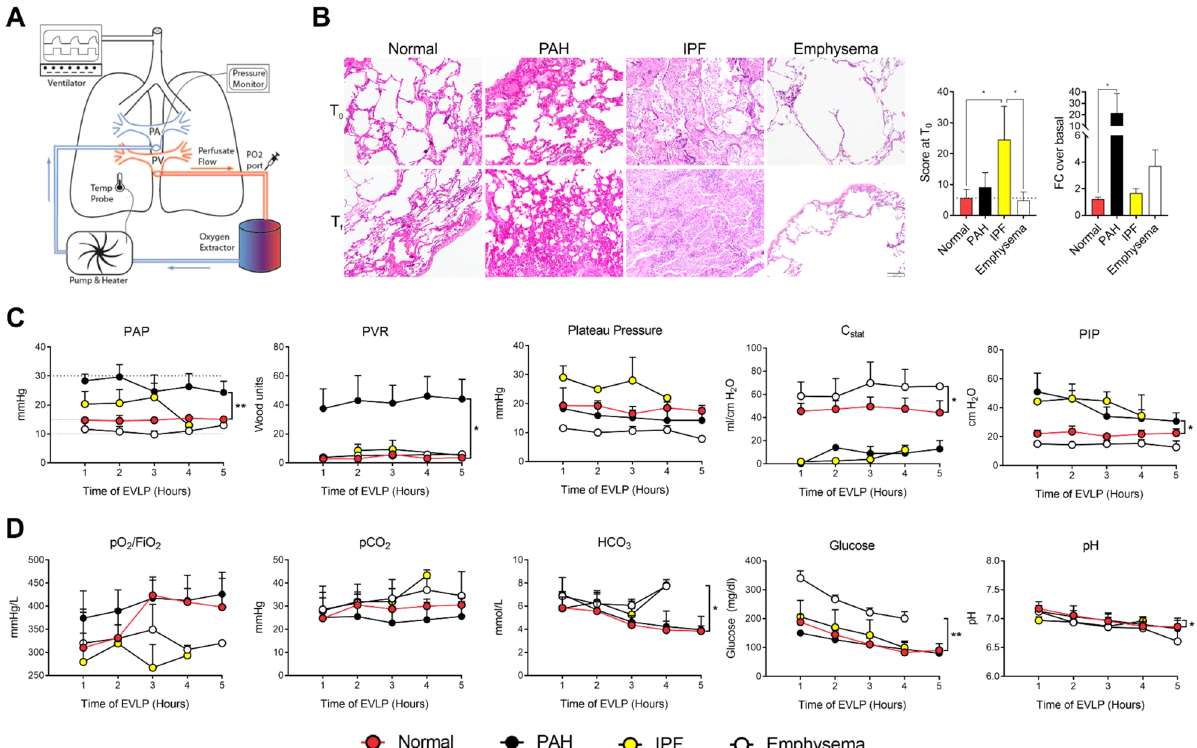
Figure 1. Human ex vivo lung perfusion. ( A ) Schematic of the experimental setup (previously published) 11 . ( B ) Kinetic analysis of Histopathology from Normal, PAH, Emphysema, and IPF Lungs during Ex Vivo Lung Perfusion (EVLP). Representative hematoxylin and eosin staining (20x) high-power magnification of lung parenchyma biopsy specimens at the beginning (0 h) and end of perfusion (6 h) shows maintenance of lung architecture. Quantification of the blind scoring of histology images is shown in bar graphs for time 0 and as fold change (FC) of end of EVLP over start. ( C ) Pulmonary artery pressure, PVR, peak Airway pressure, static lung compliance, and Peak Inspiratory Pressure throughout EVLP. ( D ) Gas exchange parameters including pO 2 , pCO 2, HCO 3 , and pH and biochemical assessment of lung metabolism by measurement of glucose throughout perfusion in normal (red), emphysema (white), IPF (grey), and PAH (black) lungs at various timepoints on EVLP. *p < 0.05; **p <